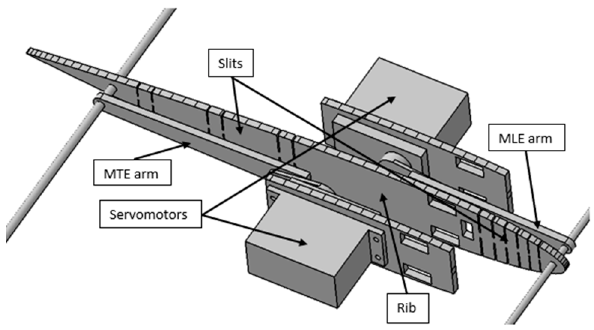
Figure 7. MCS design in CATIA V5.